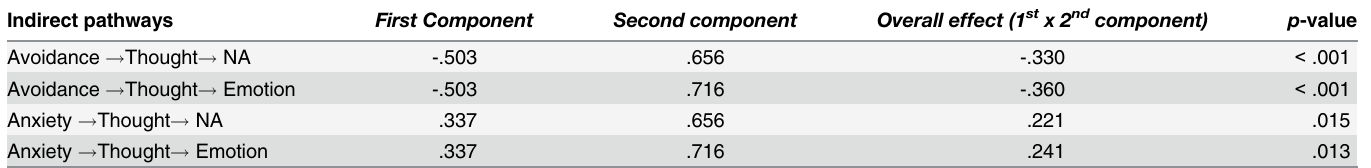
Table 2. Indirect Effects for the Mediator Model ( N =